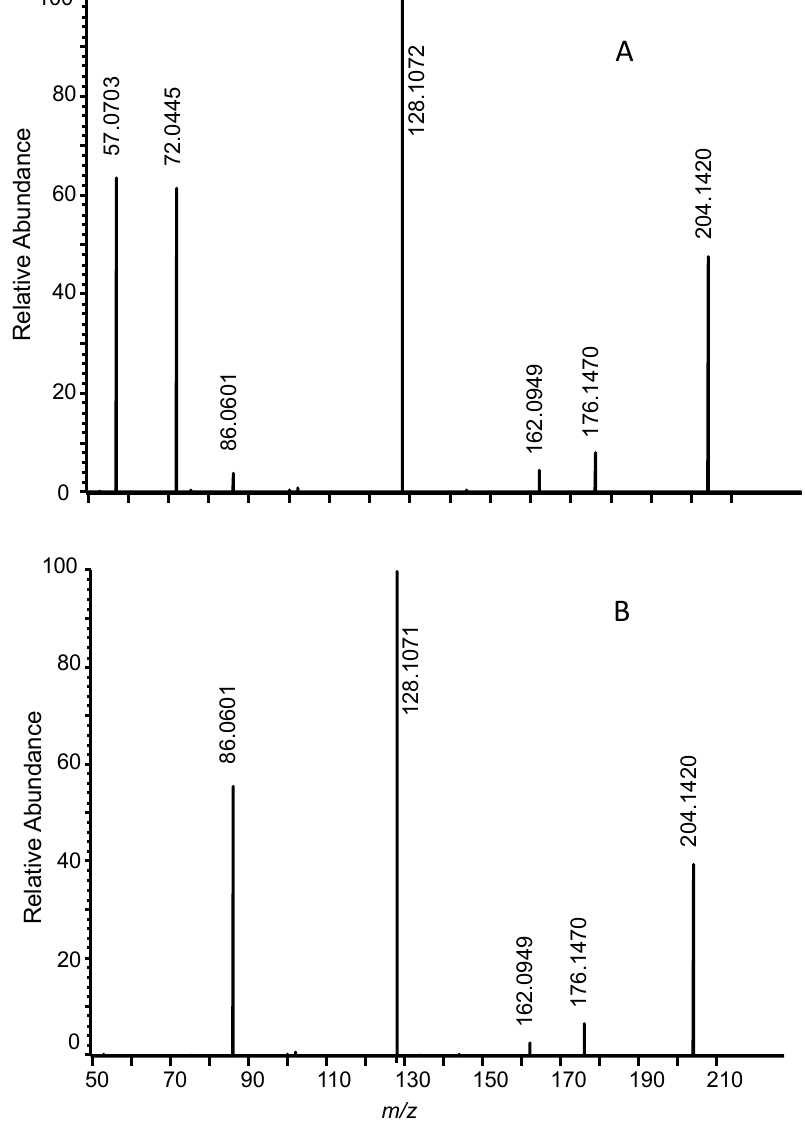
Figure 1. Positive ESI spectra obtained with an NCE 20 eV for: ( A ) pebulate and ( B ) vernolate. Scheme 1 is the proposed fragmentation pathway for these pesticides indicating formation of two ions at m/z 128 and 162 that lead to product ions at m/z 57 and 72 for pebulate, and product ion at m/z 86 for vernolate. This ion resulted from the loss of butyl group but the equivalent ion resulting from the loss of ethyl group was not observed in the spectra. It is not clear if ion at m/z 162 can lead to those product ions, and is thus shown with a question mark in Scheme 1.